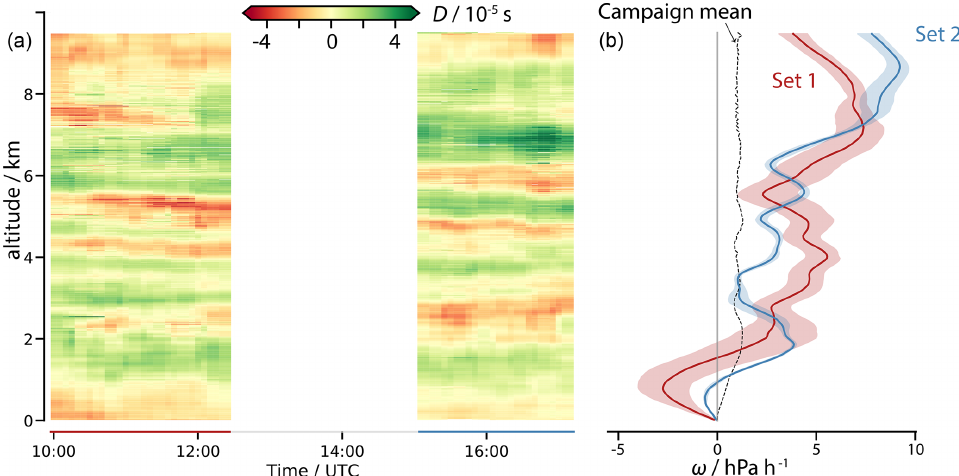
Figure 9. Divergence of the horizontal wind versus height (a) , and vertical pressure velocity versus height (b) . Divergence estimated from dropsonde measurements and vertical pressure velocity derived from these for the two sets of circles flown on 5 February. The black dashed line on the rightmost panel denotes vertical pressure velocity averaged over all EUREC 4 A-Circle dropsonde